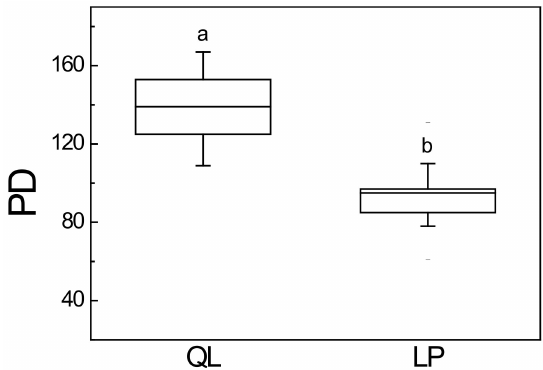
Figure 3. The phylogenetic diversity (PD) of the Qinling Mountains (QL) and the Loess Plateau (LP). The boxes show the range of values of PD in each region. The letters “a” and “b” indicate significant di ff erences between